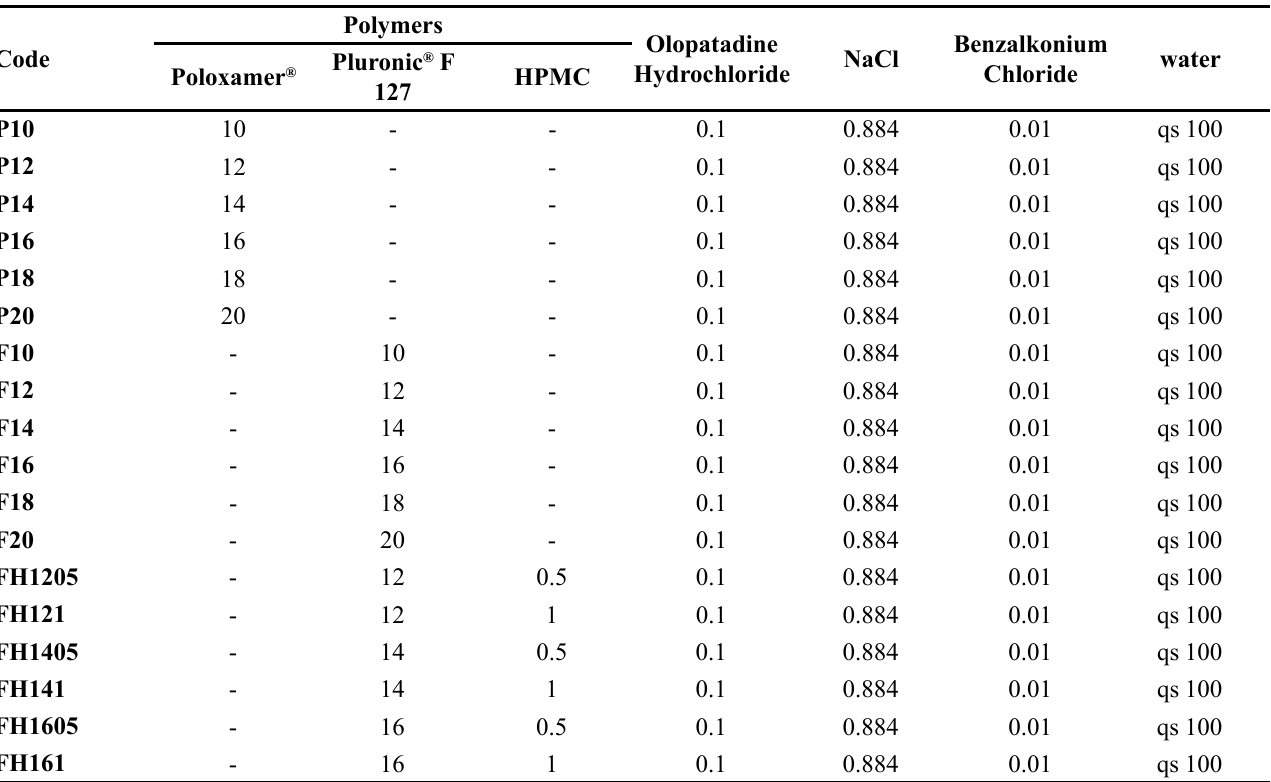
TABLE I - Composition percentage of in situ gel formulations